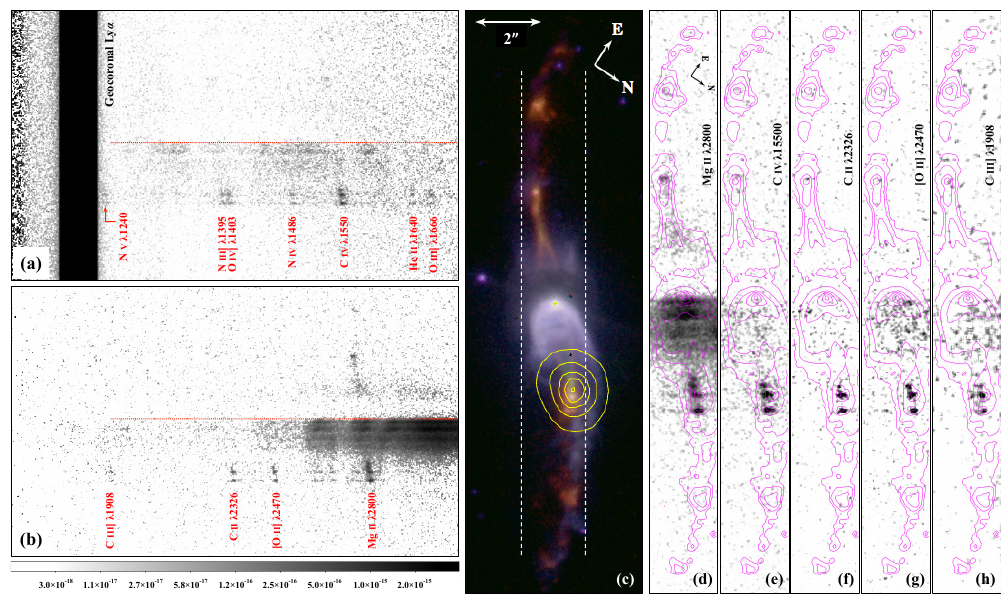
Figure 1. ( Left ) Negative grayscale images of the STIS FUV-MAMA ( a ) and NUV-MAMA ( b ) spectra of Hen3-1475; emission features are identified. Note the bright geocoronal Ly α . Red dotted lines mark the position of the central star. The color bar below shows the grey scale coded in flux values (in units of ergs − 1 cm − 2 Å − 1 ). Panel ( c ): HST 2009 WFC3 color-composite image of Hen3-1475 created with F658N (red), F656N (green), and F555W (blue) and overlaid with Chandra X-ray emission contours (yellow; Obs. ID 2580, PI: R. Sahai); white dashed lines indicate the STIS 52 (cid:48)(cid:48) × 2 (cid:48)(cid:48) long slit (PA = 124. ◦ 65). Panels ( d – h ): STIS UV spectral-line images (see legend) overlaid by WFC3 F658N emission contours (magenta); the panels are displayed in negative greyscale and slightly smoothed to reduce